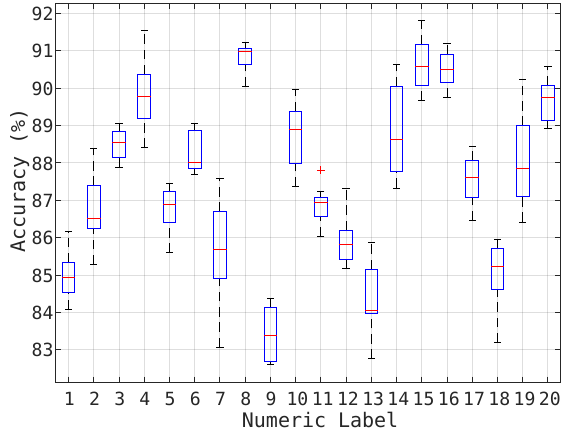
Figure 7. Accuracy boxplots of the birdsong classifier obtained from the 10-fold cross-validation. The numerical labels correspond to the species listed in Table